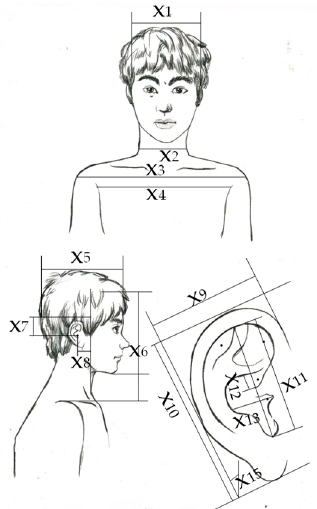
Figure 6. The anthropometric features used in the presented integrated method. x 14 is the seated height, which is not marked in the figure.